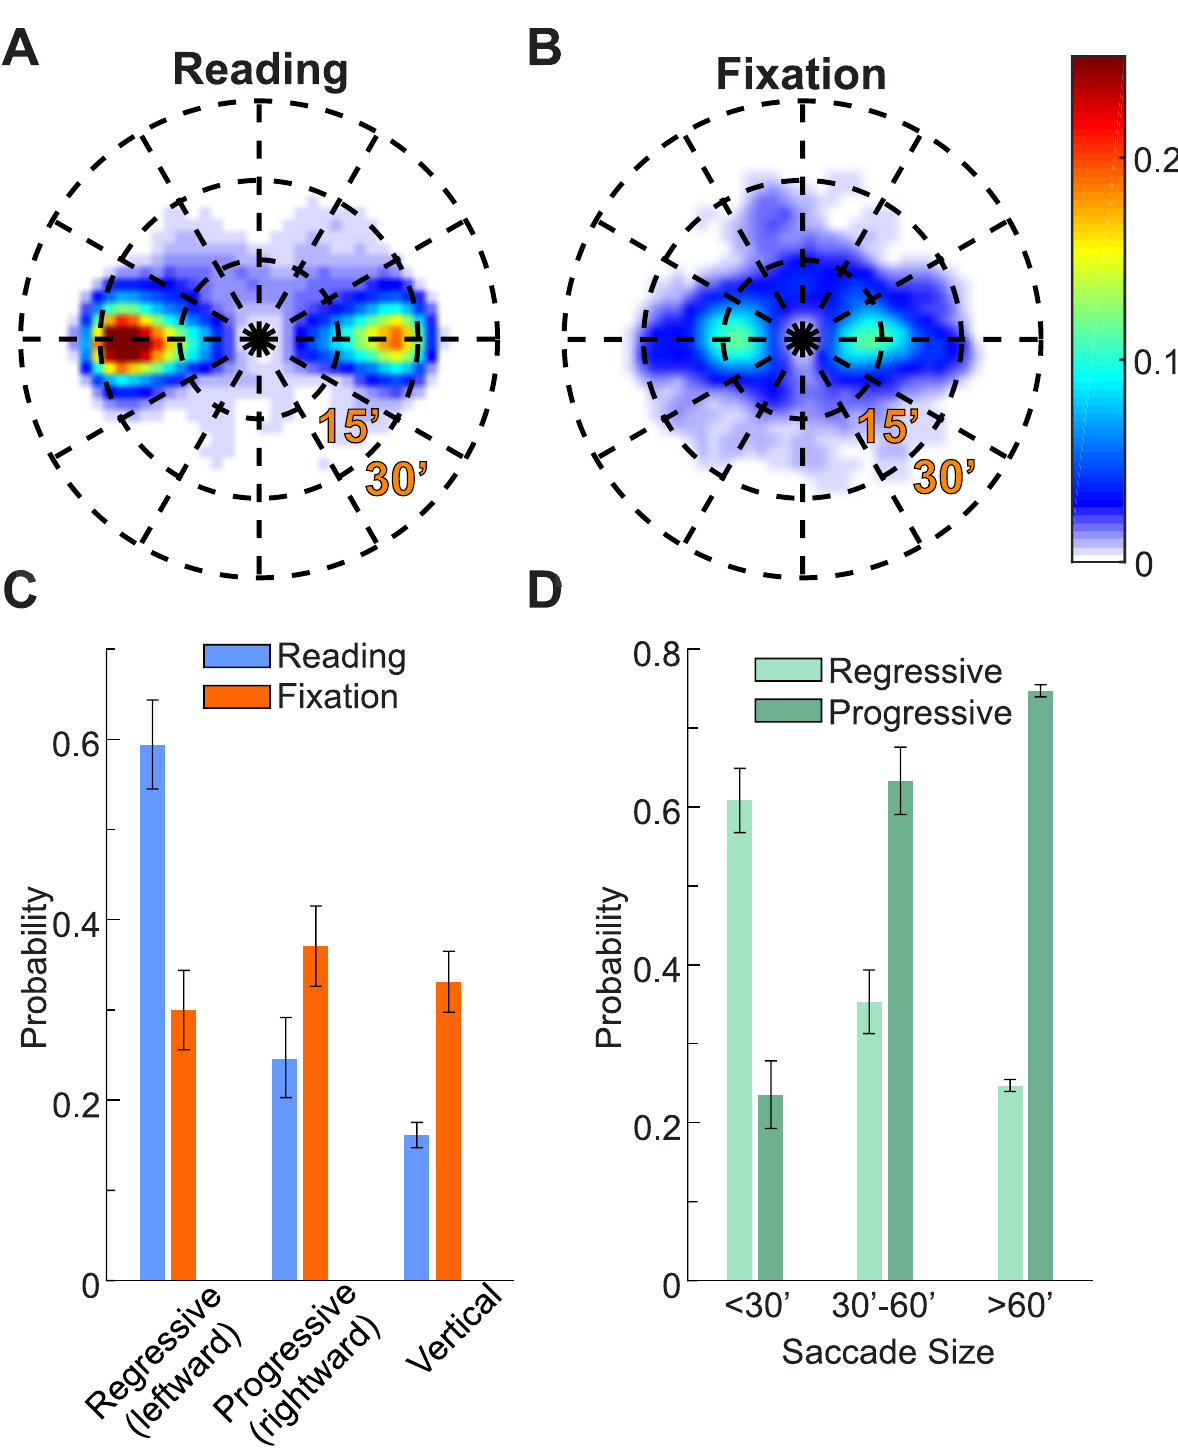
Fig 3. Microsaccades and saccadesdirection. Average 2D polar histogramsof microsaccades direction and amplitudeduringreading ( A ) and sustainedfixation ( B ). ( C ) Average probabilityof microsaccade directionduringreadingand duringsustainedfixation. Microsaccade direction was classifiedinto three different categories; progressive (rightward), regressive (leftward) and vertical (up and downward). ( D ) Average probabilityof regressive and progressive saccades duringreadingas a function of saccade amplitude. Error bars represent